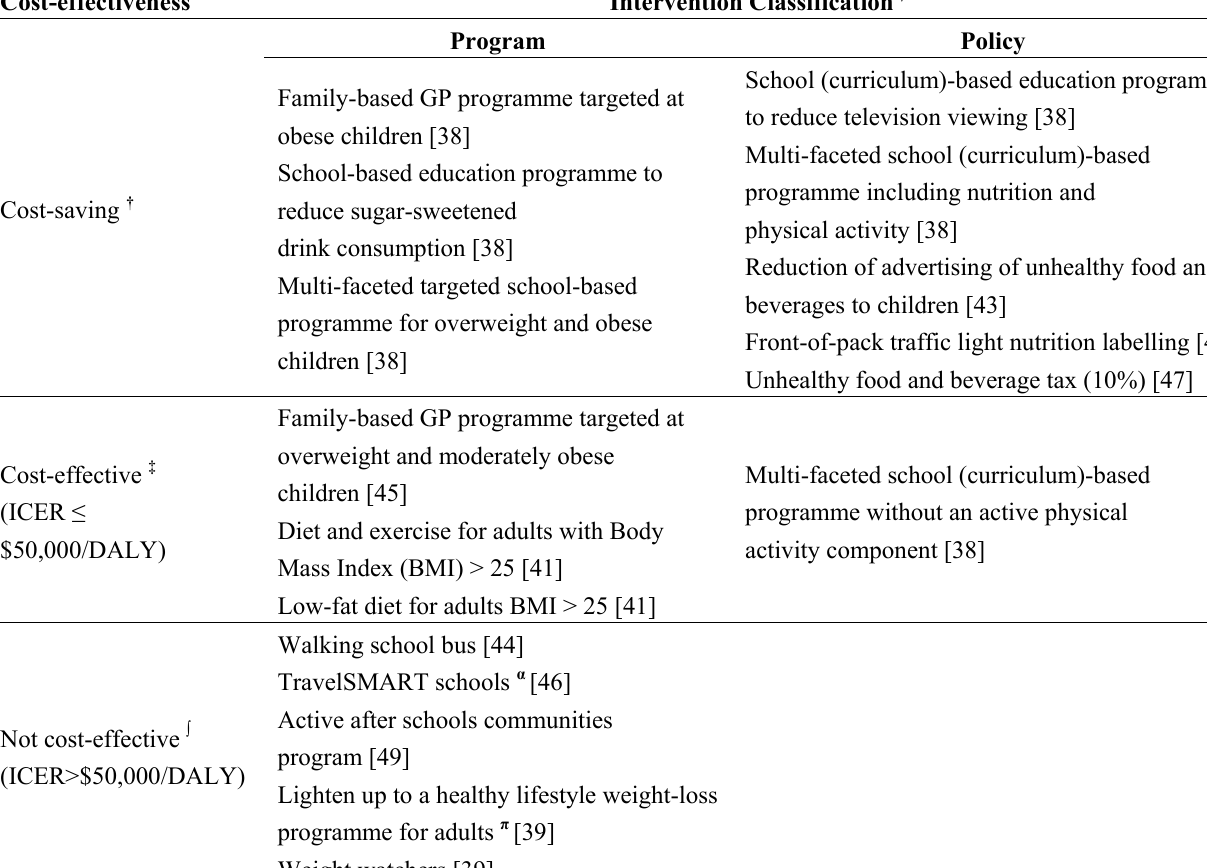
Table 2. Cost-effectiveness of program versus policy interventions from the Assessing Cost-Effectiveness (ACE)-Obesity and ACE-Prevention